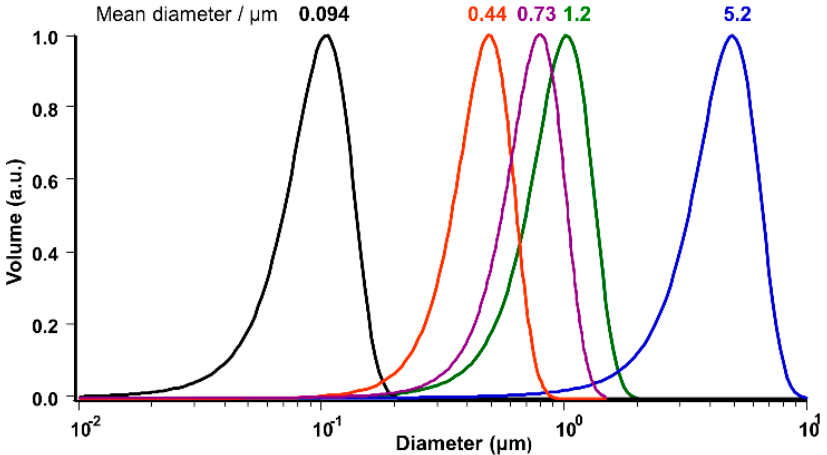
Figure 2. Size distribution analysis for egg yolk phosphatidylcholine (EPC)-vesicles by dynamic light scattering (DLS).